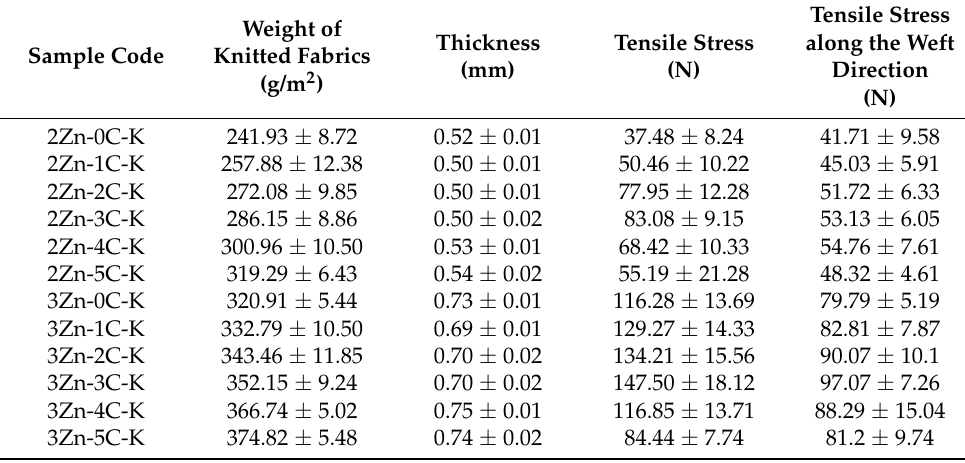
Table 2. Specifications of functional antibacterial knitted fabrics.